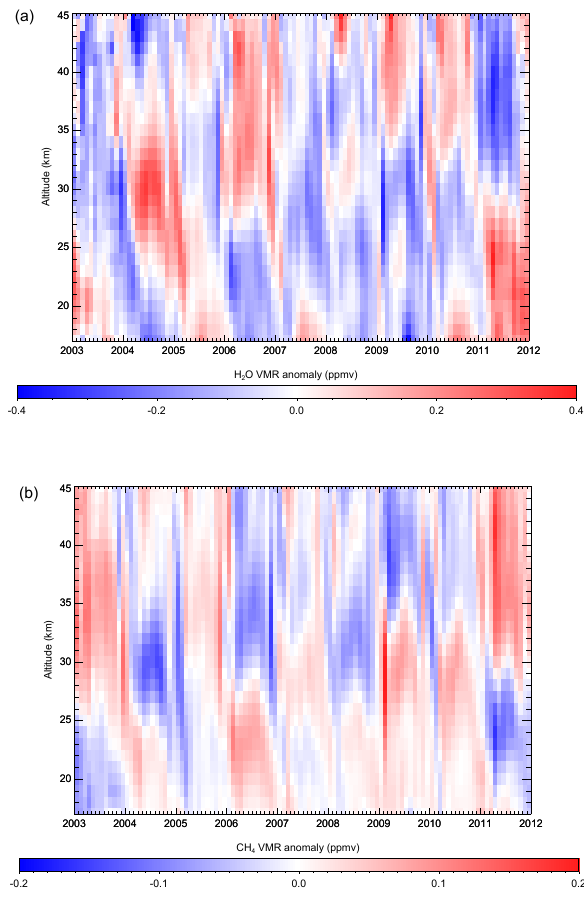
Figure 7. Time series of SCIAMACHY H 2 O (a) and CH 4 (b) monthly VMR anomaly profiles from January 2003 to December 2011. The CH 4 plot is taken from Noël et al. (2016). Note that for these data the same latitudinal dependence as shown in Fig. 6 still